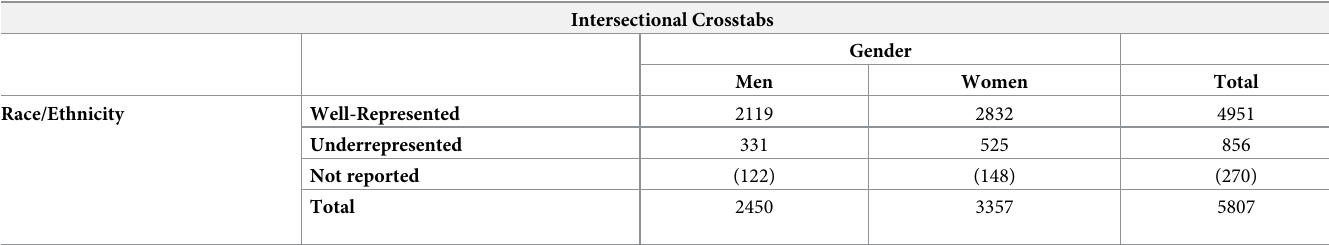
Table 1. Number of respondents by race/ethnicity and